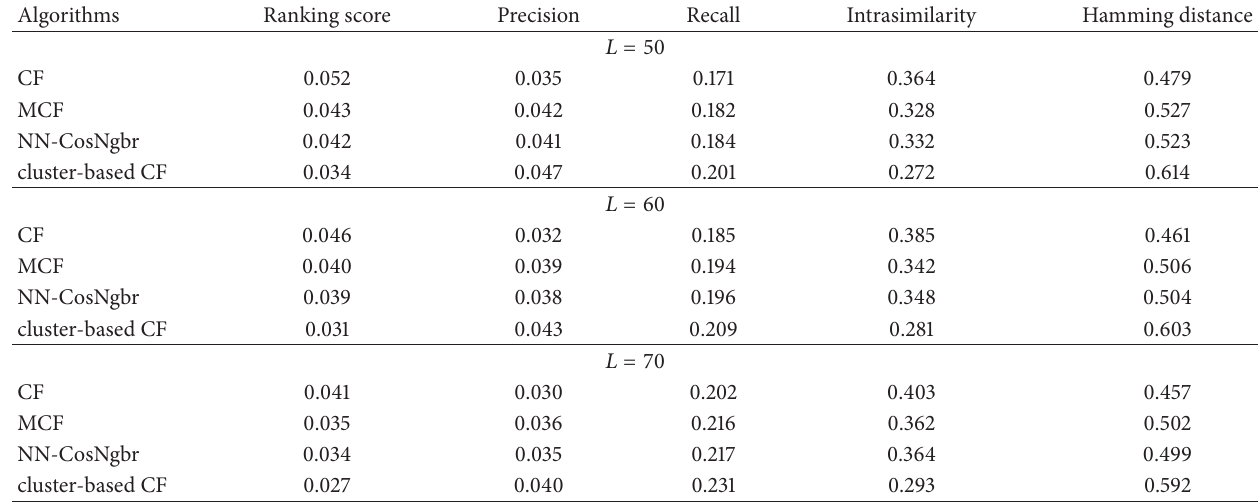
Table 3: Algorithmic performance for the real-world dataset. The ranking score, precision, recall, intrasimilarity, Hamming distance are corresponding to 𝐿 = 50, 60, and 70. Each number presented in this table is obtained by averaging over five runs, each of which has an independently random division of training set and